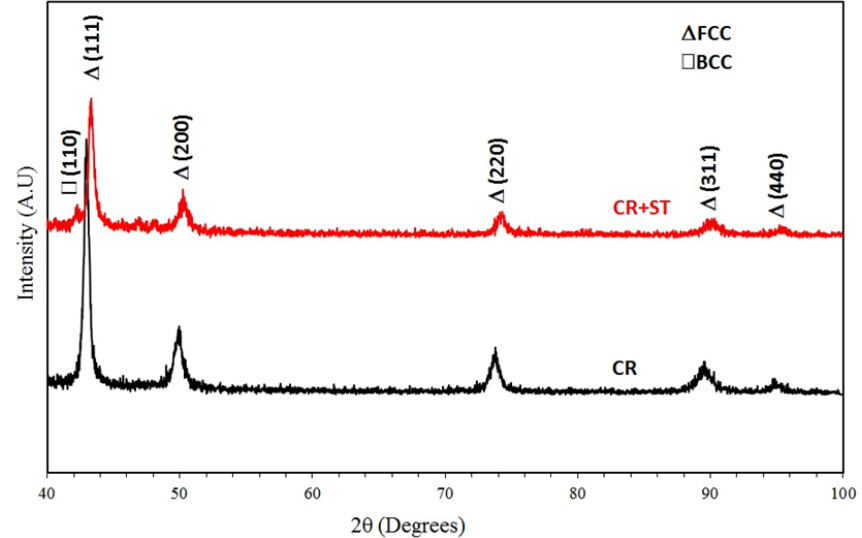
Figure 6. XRD patterns of the cold rolled (CR) and solution-treated (CR + ST) Fe 36 Mn 20 Ni 20 Cr 16 Al 5 Si 3 HEA [23].